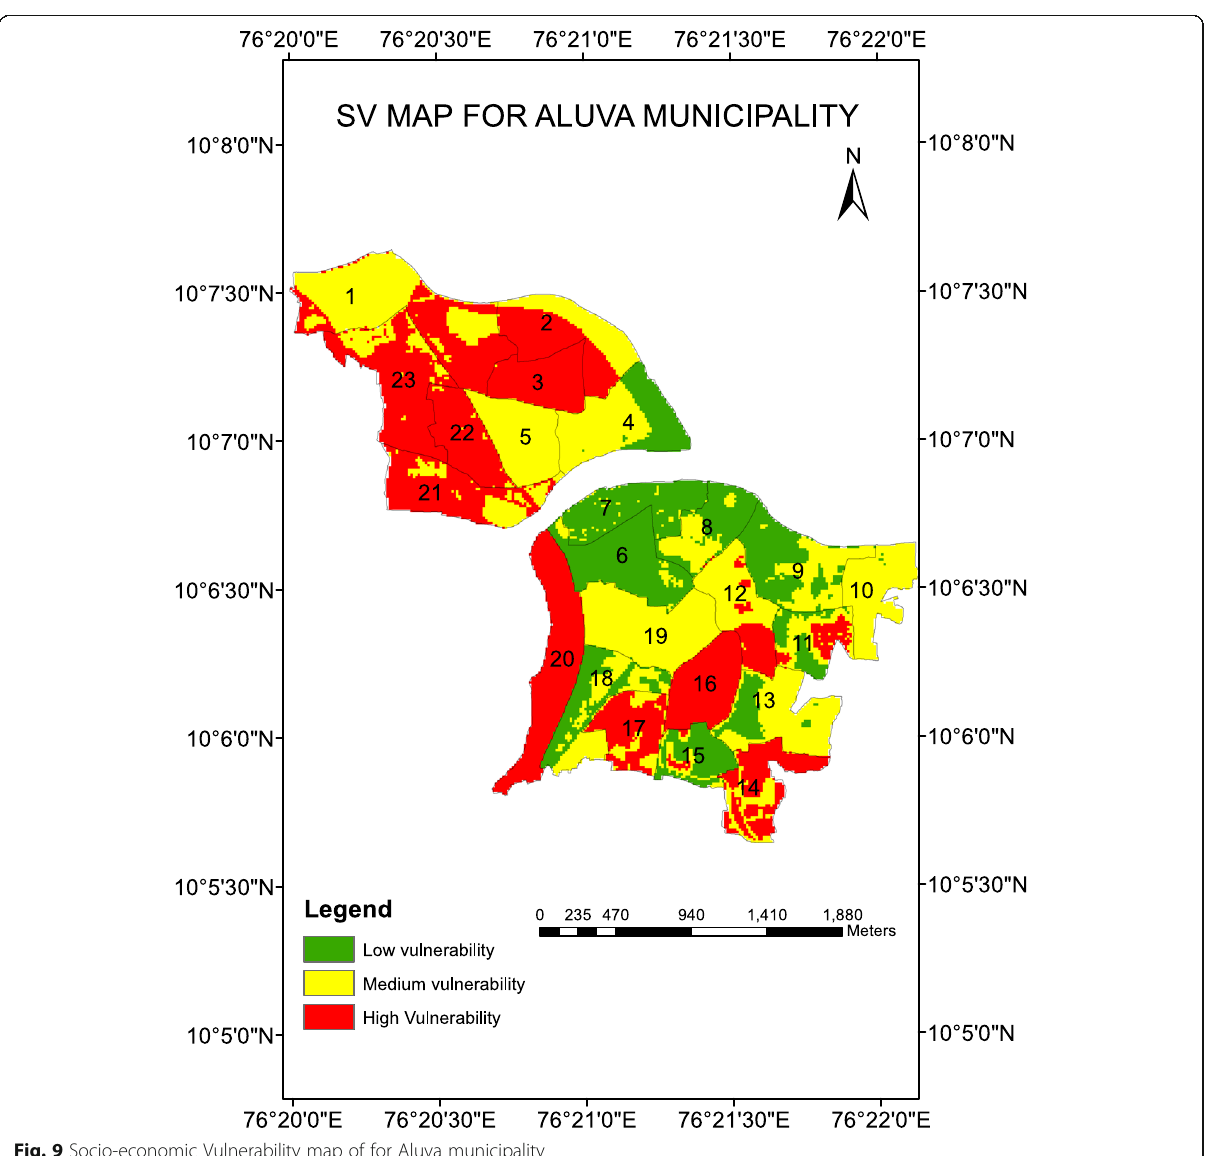
Fig. 9 Socio-economic Vulnerability map of for Aluva